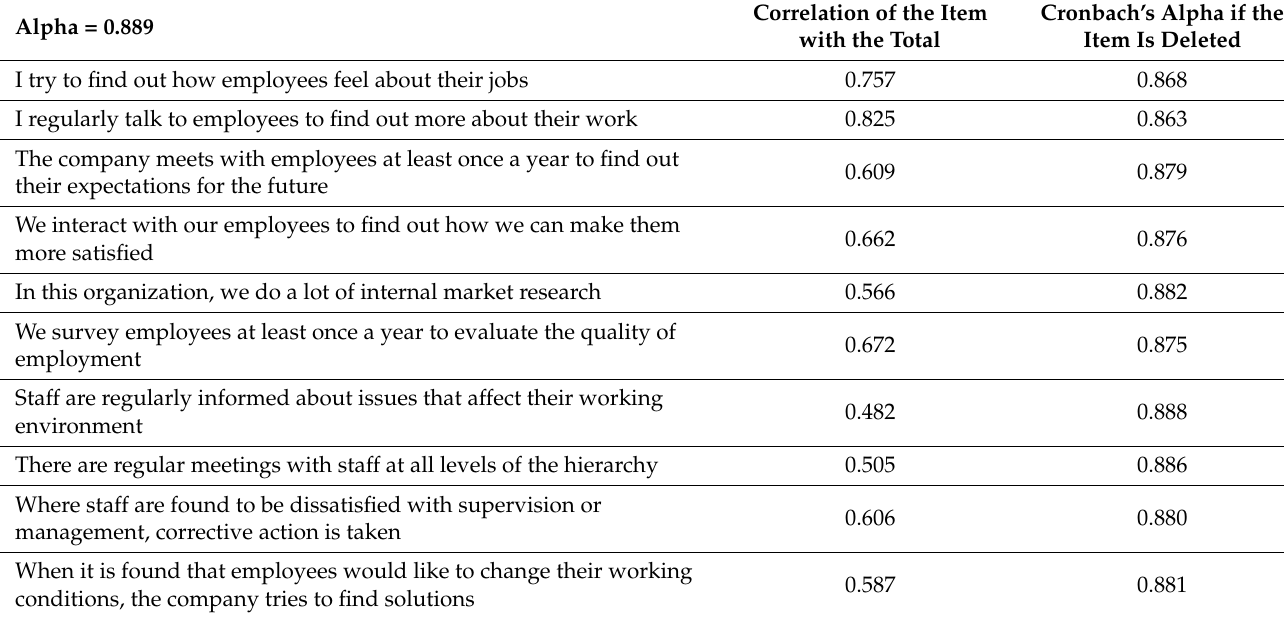
Table 10. Internal market orientation and internal communication